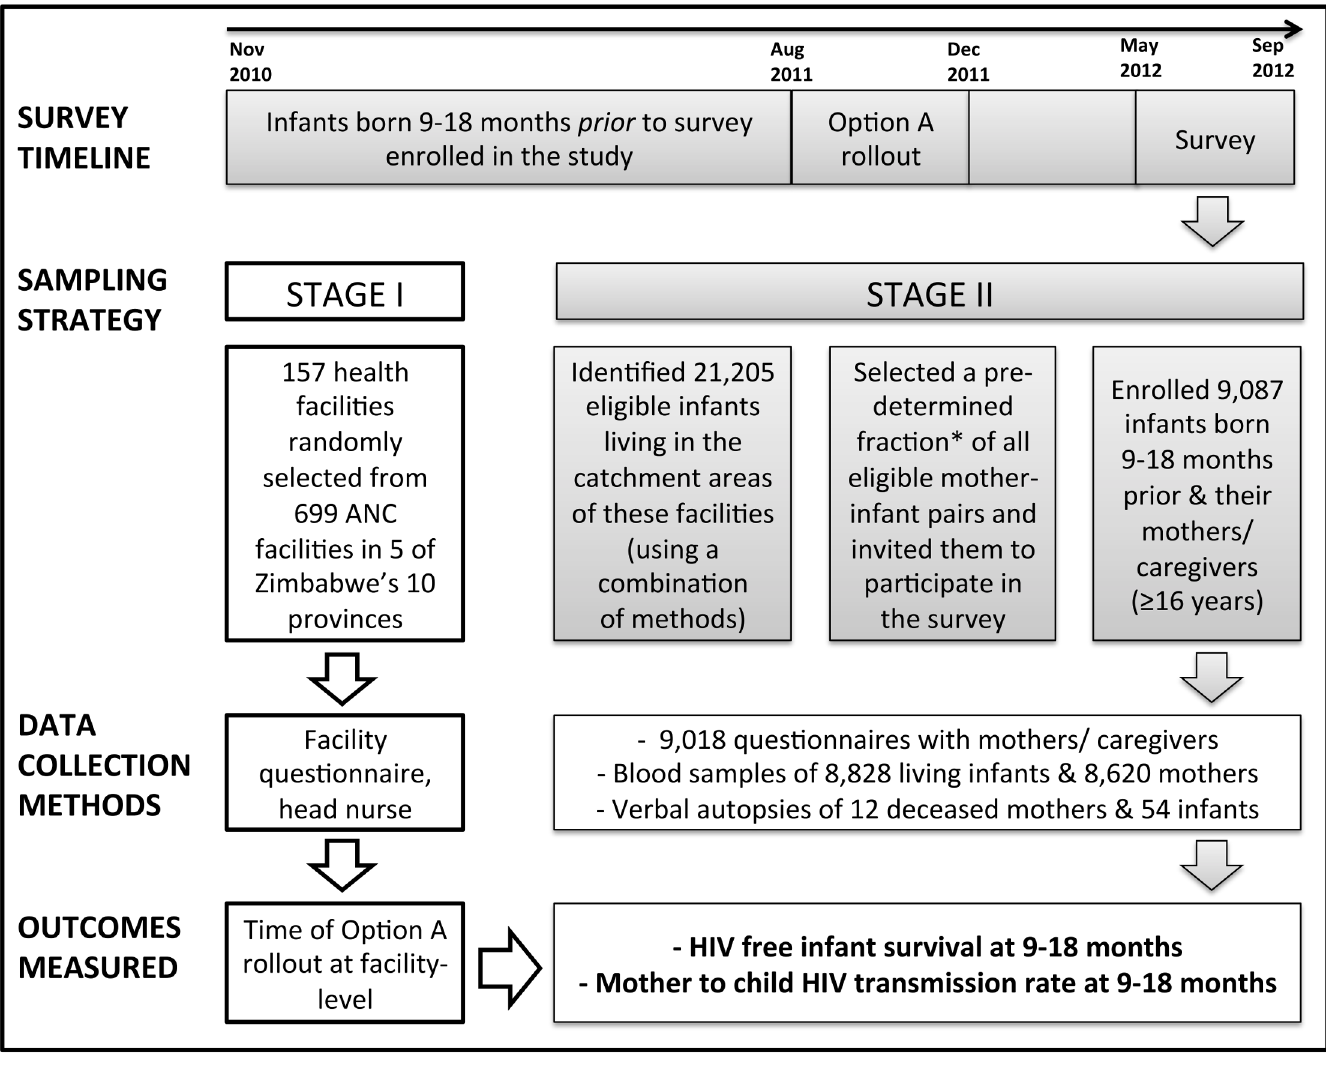
Fig 1. Survey timeline, sampling strategy, data collection methods and outcomes measured for the 2012 survey of the impact evaluation of Zimbabwe ’ s Accelerated PMTCT program. * In each catchment area, we used one of the following sampling fractions (so that we enroll an average of 50 mother-infant pairs per catchment area, which was one of the assumptions of our power calculations): 1) 1 in 4 eligible mother-infant pairs if the catchment area had over 300 eligible infants, 2) 1 in 2 infants if the catchment area had 150 to 300 eligible infants, or 3) all the mother-infant pairs if the catchment area had fewer than 150 eligible